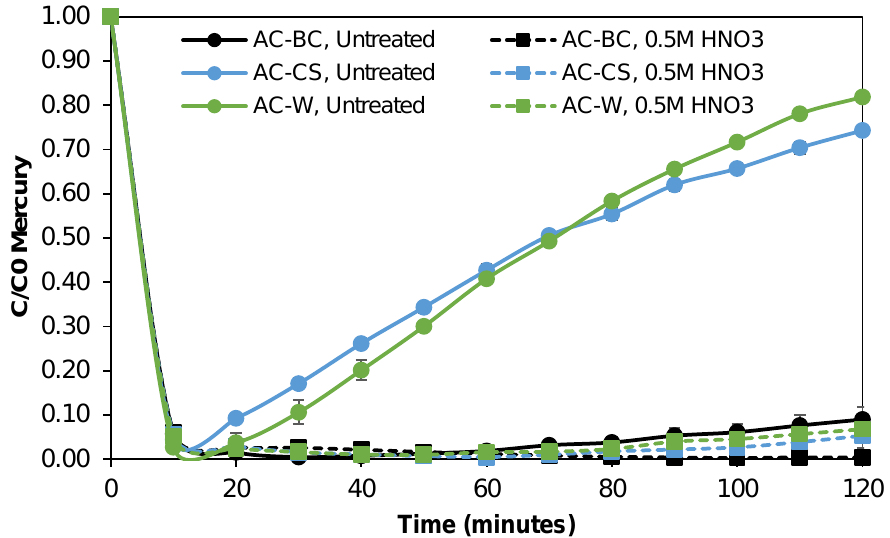
Figure 8. Treated and untreated activated carbon’s removal of mercury over time.